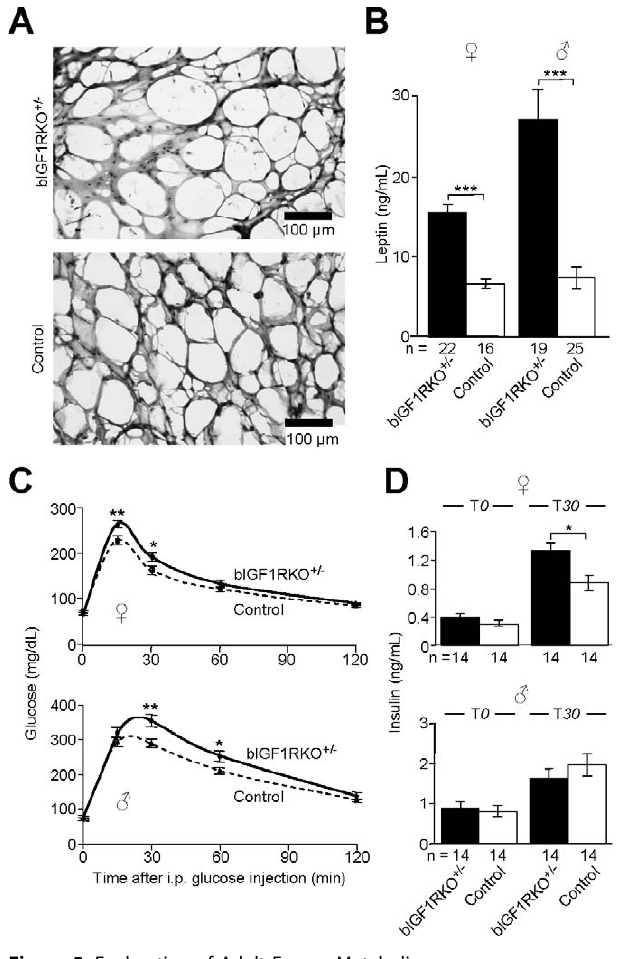
Figure 5. Exploration of Adult Energy Metabolism (A) bIGF1RKO þ / (cid:2) adipocytes from inguinal AT were abnormally enlarged. (B) Leptinemia was very high in bIGF1RKO þ / (cid:2) mice, and strongly correlated with individual total AT size in all animals ( R ¼ 0.76, p , 0.0001, n ¼ 82). (C) Glucose tolerance was impaired in bIGF1RKO þ / (cid:2) males and females. (D) 30 min after intraperitoneal glucose injection (T 30 ), the plasma insulin concentration was, as expected, significantly increased in mutants and controls. However, although bIGF1RKO þ / (cid:2) females responded to elevated blood glucose with adequate hyperinsulinemia, bIGF1RKO þ / (cid:2) males did not, suggesting a secretory